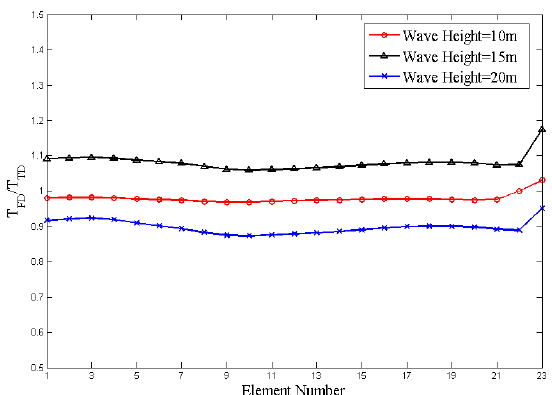
Figure 14. The ratio of dynamic tension amplitude in the frequency domain and time domain under a regular wave.